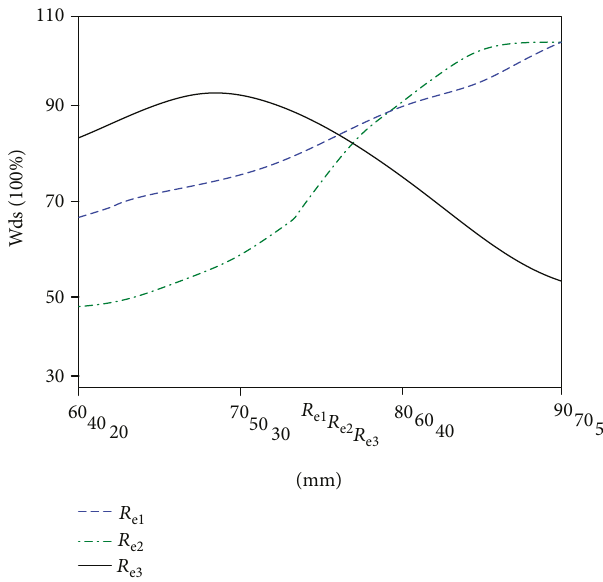
Figure 9: The in fl uence curve of structural parameters on the kinematic decoupling workspace volume